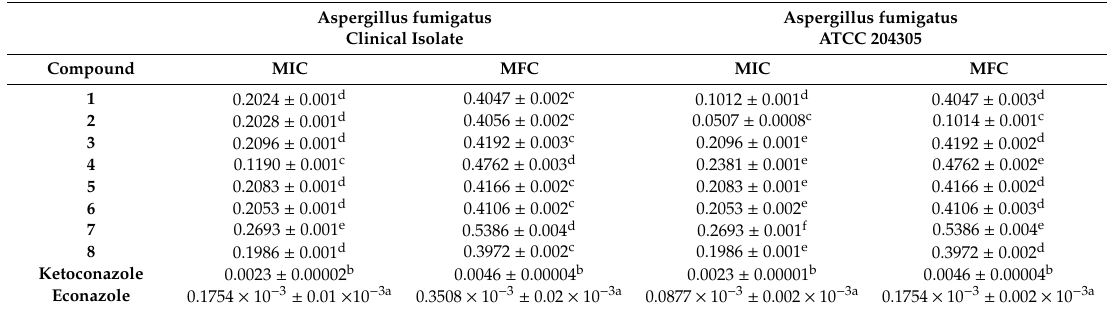
Table 6. Minimal inhibitory (MIC) and fungicidal (MFC) concentration values of the proposed ( 1 – 8 ) compounds ( µ mol · mL − 1